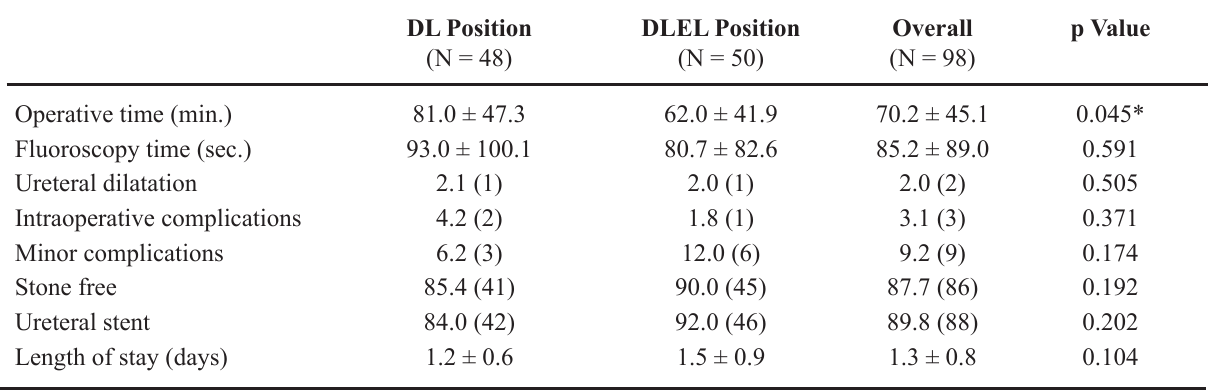
Table 2 – Intraoperative characteristics according to dorsal lithotomy (DL) position and to dorsal lithotomy with extended leg (DLEL)